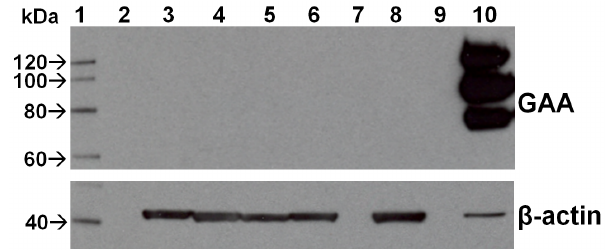
Figure 2. Representative Western gel blot showing CRIM negative status of four patients (lanes 3–6). Lane 1- protein magic marker; lane 8 -CRIM negative control cell line; lane 10 - normal human fibroblast (NHF) control; Lanes 2, 7 and 9 - left empty. 20 ug of skin fibroblast cell protein extract was loaded for each patient lane and 2.5 ug protein was loaded for NHF. Western blot was probed with anti- GAA antibody and ß-Actin was used as a protein loading control.